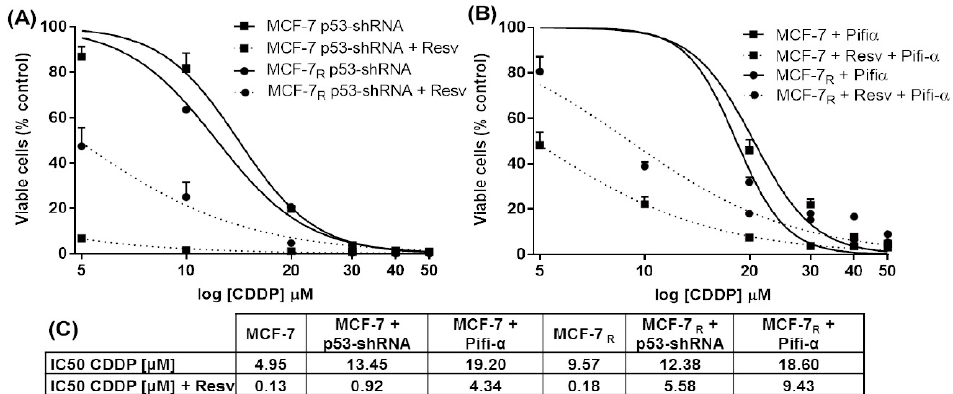
Figure 2. Down-regulation of p53 expression and inhibition of the p53 protein activity enhances resistance to CDDP and Resv in MCF-7 and MCF-7 R cells. ( A ) p53-shRNA transfected cells and ( B ) MCF-7 and MCF-7 R cells were pretreated with 10 μ M of pifithrin- α (Pifi- α ) for 24 h; both were treated for 48 h with indicated CDDP concentrations with or without Resv (100 μ M). Cell viability was tested by MTT assay. Each data point is the mean of three independent experiments ± SD. ( C ) A summary of the IC 50 values for CDDP that were calculated by nonlinear regression (curve fit) by log[CDDP] vs. normalized response–variable